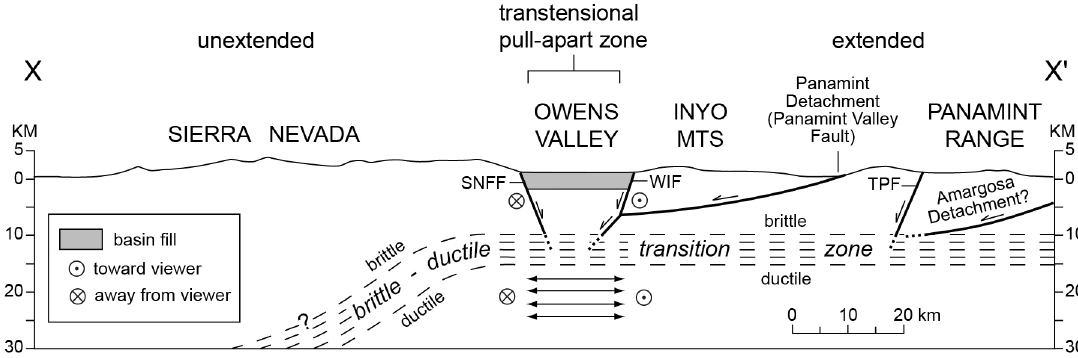
Figure 13. Cross section X-X' (Figure 2) illustrating possible structure of the Owens Valley transtensional graben. Horizontal arrows represent ductile extension below Owens Valley. See text for further discussion. SNFF, Sierra Nevada Frontal Fault; TPF, Towne Pass Fault; WIF, West Inyo Fault. No vertical